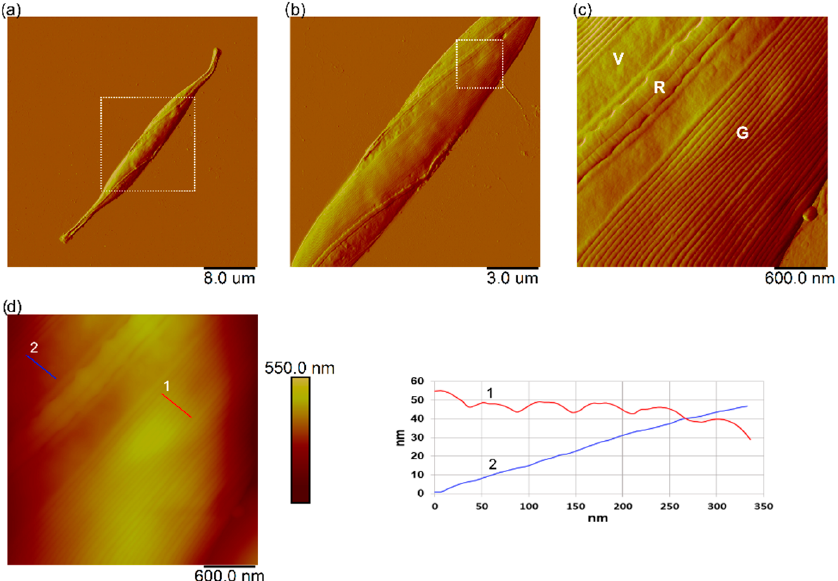
Figure 8. AFM images of Cylindrotheca closterium cell from control culture. AFM images of the whole C. closterium cell ( a ) and its morphological details ( b – d ). Vertical profiles along indicated lines in ( d ) along girdle band (red line, number 1) and valve (blue line, number 2) are shown next to image. Images are acquired using contact mode in air with scan sizes: 40 µm × 40 µm ( a ), 15 µm × 15 µm ( b ), 3 µm × 3 µm ( c , d ) and presented as deflection ( a – c ) and height data ( d ). Letters V, G, and R indicate the following features: valve, girdle band, and raphe opening, respectively.